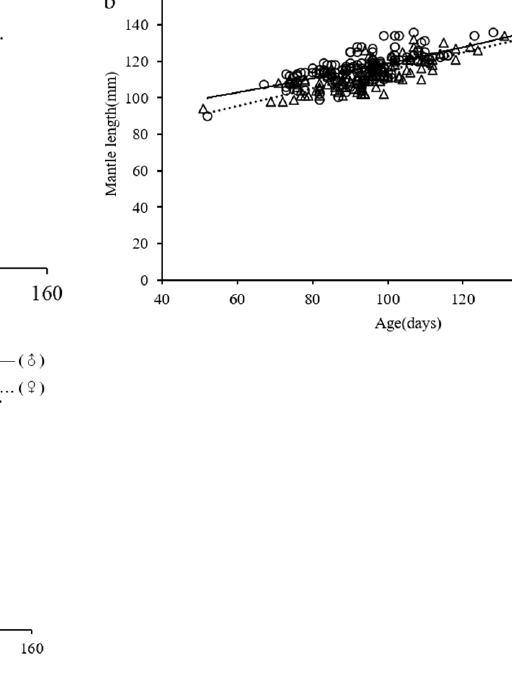
Figure 7. ML–BW ( a ), ML–age ( b ), and BW–age ( c ) relationships of B. magister shevtsovi .